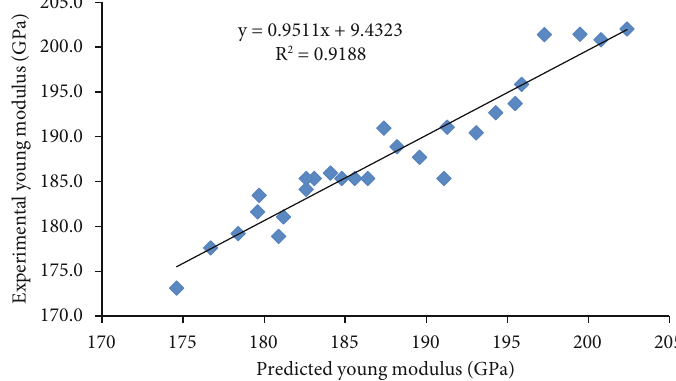
Figure 7: Young modulus experimental versus predicted values.